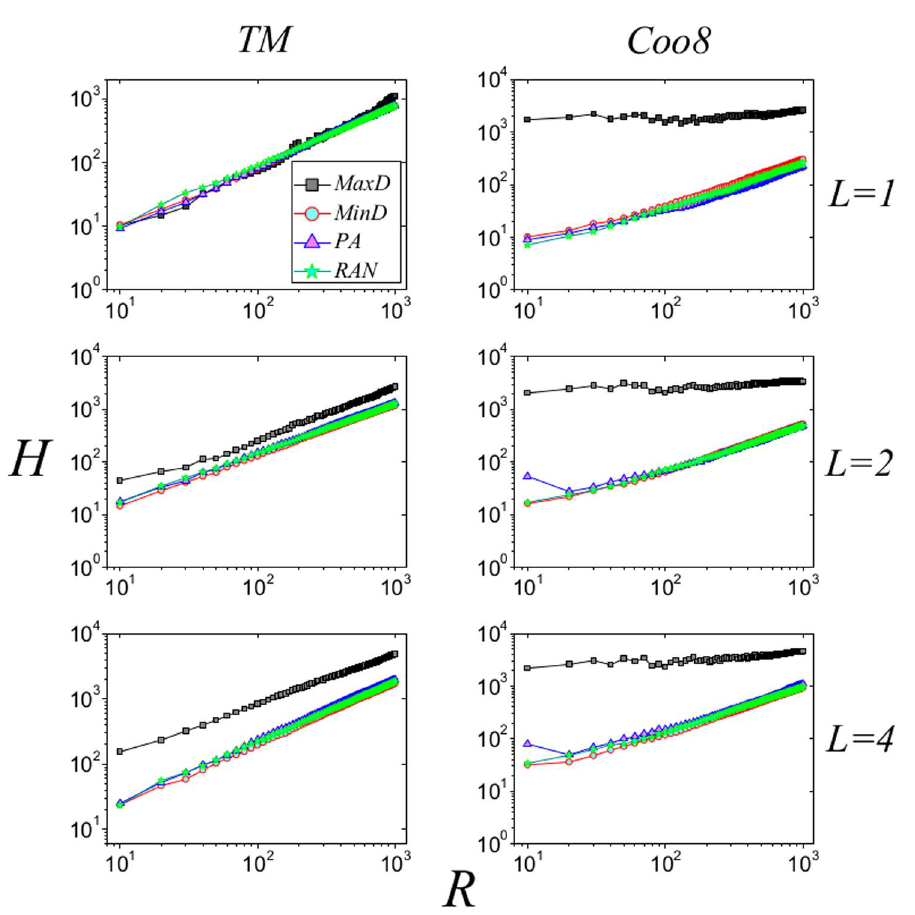
Figure 4. Performance of the four strategies for reshuffled networks. The results of MaxD, MinD, PA and RAN are represented by black squares, red circles, blue triangles and green pentagrams, respectively. Data points are obtained by averaging over 100 independent